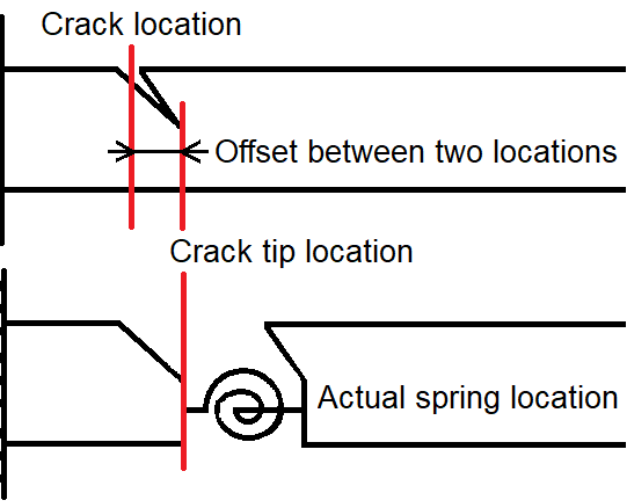
Figure 6. Schematic of the actual crack tip and torsional spring location for inclined crack. When the solid structure of a beam with an inclined crack is converted into a beam– spring–beam system, there is, in fact, a connection only at the crack tip location. In other words, the beam on the right is actually moving around the tip of the inclined crack instead of the initial crack location. Likewise, the continuity between the beam on the left and the torsion spring is at the crack tip in the beam–spring–beam system. The reference point of the coordinate system for the motion of the beam on the right is shifted from the initial position of the crack to the crack tip compared to the case of a vertical crack. The horizontal distance of this offset can be expressed in Equation (5), where θ denotes the crack